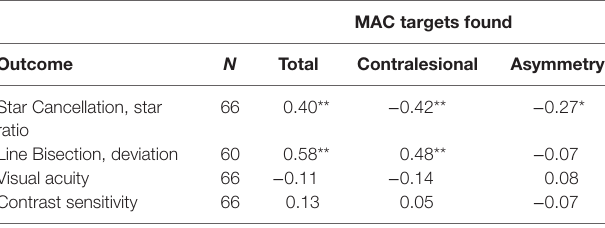
TaBle 3 | Spearman correlations between MAC, Star Cancellation, Line Bisection, contrast sensitivity, and visual acuity.